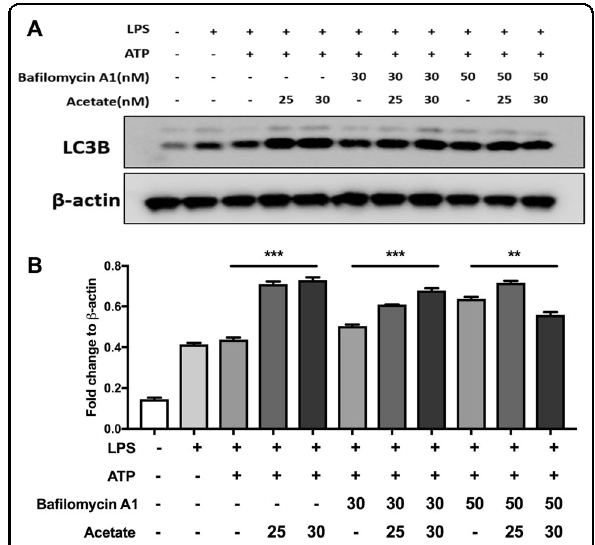
Fig. 7 Acetate enhances autophagy in a dose-dependent manner. a , b Western blot ( a ) and quanti fi cation ( b ) of LC3B after treatment with ba fi lomycin A1 and acetate (mM) ( n = 3) in BMDMs. n = biological replicates. Data are presented as the mean ± SEM. ** P < 0.01 and *** P < 0.001, one-way ANOVA for comparisons of